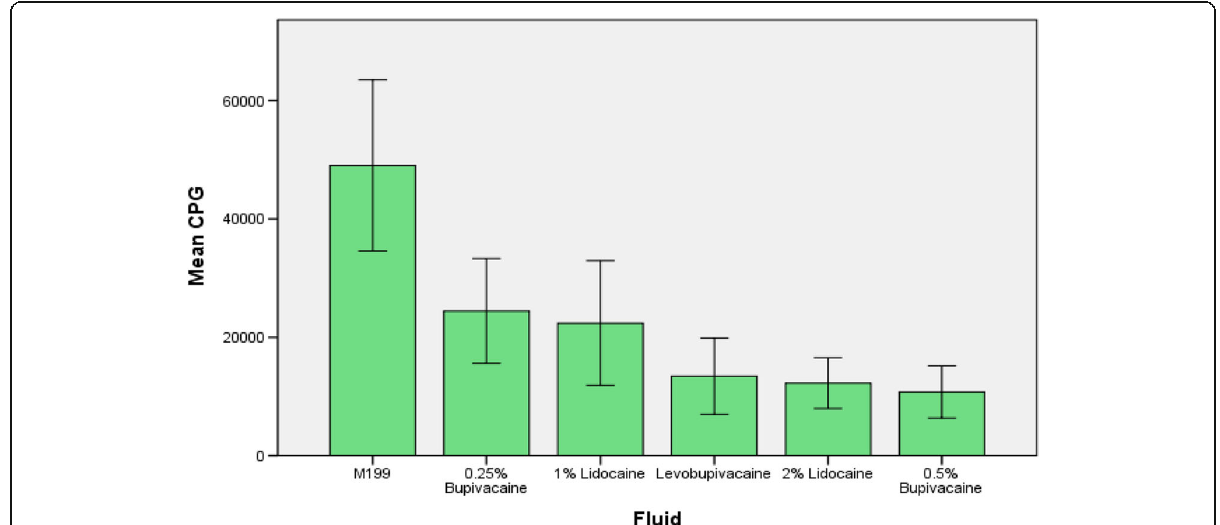
Fig. 2 Percentage inhibition of proteoglycan metabolism compared to a control solution after exposure to different local anaesthetic solutions